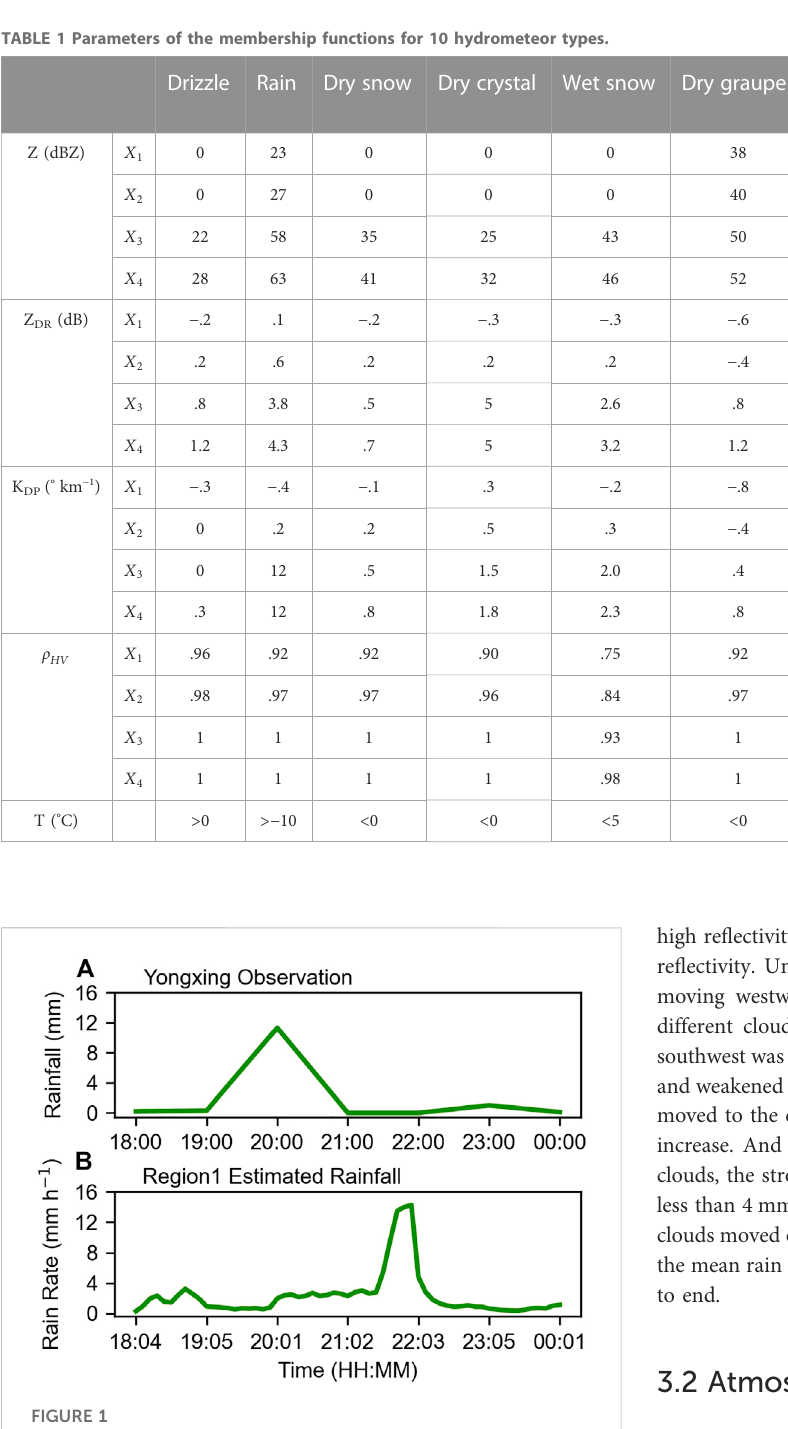
Figure 3 delineates large-scale circulation at 17:00 on 16 October. At 200 hPa, the northern SCS was controlled by the South Asian High, and there was a divergence in the upper level (Figure 3A). The East Asian Trough at 500 hPa in the middle and high latitudes was located in the east of 120 ° E (Figure 3B). The continental high corresponding to the upper trough carried strong cold air southward (Figure 3D). The ridge of Western Paci fi c Subtropical High at 500 hPa was located near 28 ° N and extended west to 95 ° E. Therefore, the warm and humid air fl ow on the southwest side of the subtropical high was conducive to the transport of water vapor and the development of ascending motion. In the lower layers (700 hPa and below), ITCZ controlled the northern SCS and a tropical depression formed in the ITCZ.